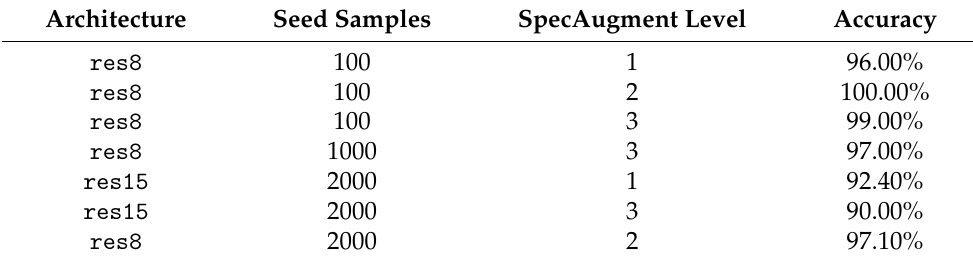
Table 7. Test accuracy of the pre-trained classifiers on surrogate samples.